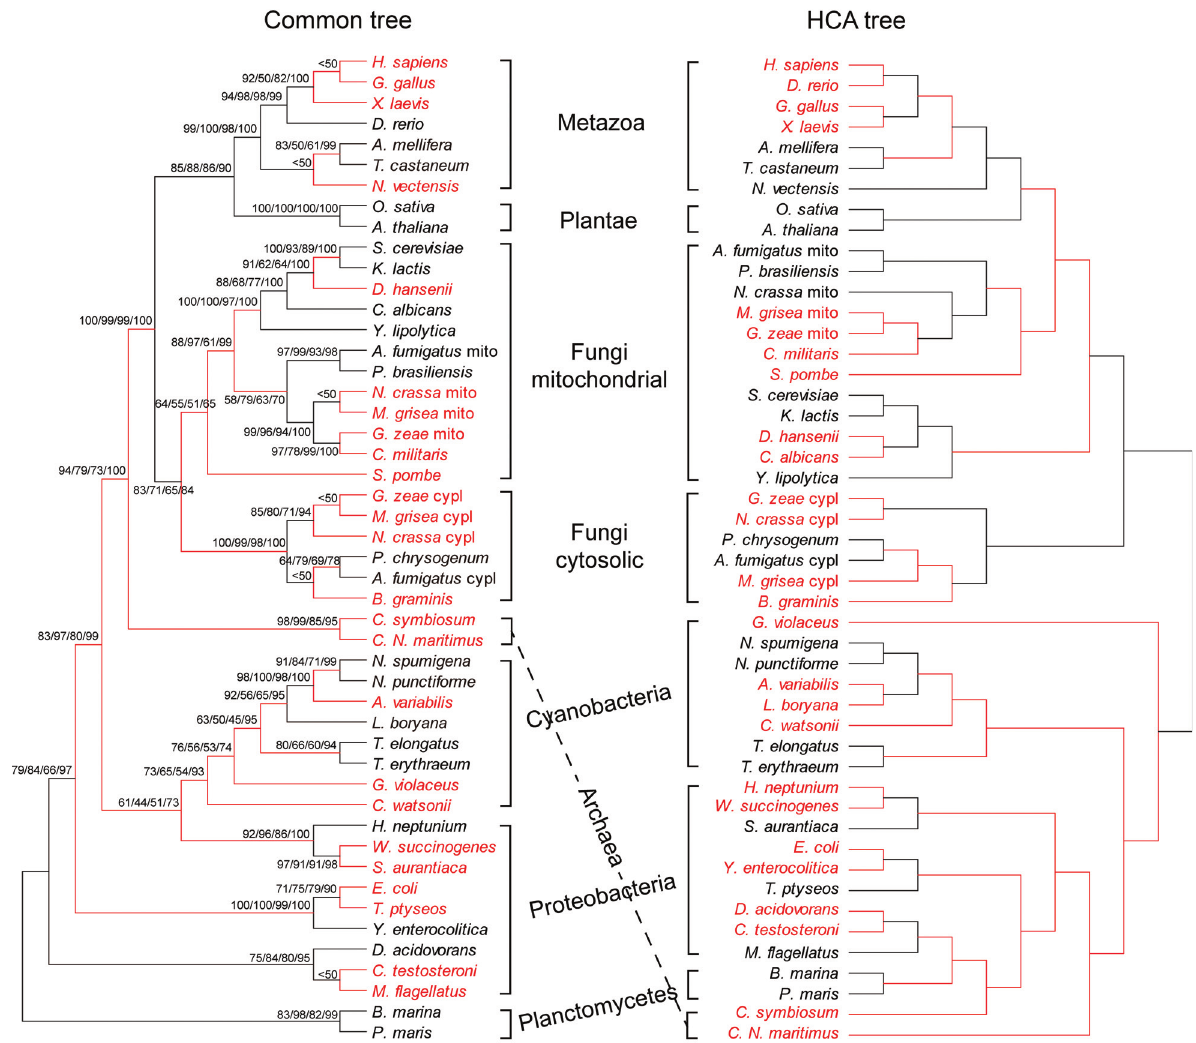
Figure 1 - Comparison of phylogenetic trees, based on the amino acid sequences of the MnSOD gene (left, Common tree) and the pairwise hydrophobic cluster analysis of the same gene (right, HCA tree). All organisms were classified clearly in both trees. Nodes with bootstrap values of maximum likeli- hood, neighbor joining and maximum parsimony methods, and Bayesian posterior probabilities respectively are shown in the consensus tree (order: ML/NJ/MP/Bayesian). The species indicated in red show differences between two trees as determined by the Tree Juxtaposer program based on the low- est BCN